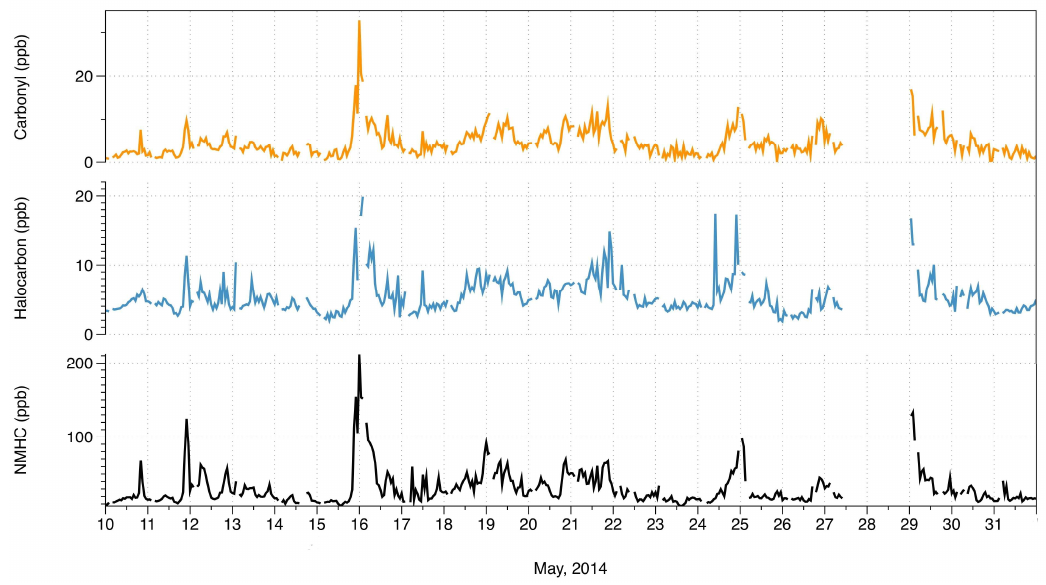
Figure 2. Time series of the total concentrations of NMHC, halocarbons, and carbonyls. Data is missing from 27 to 28 May due to instrument calibration.